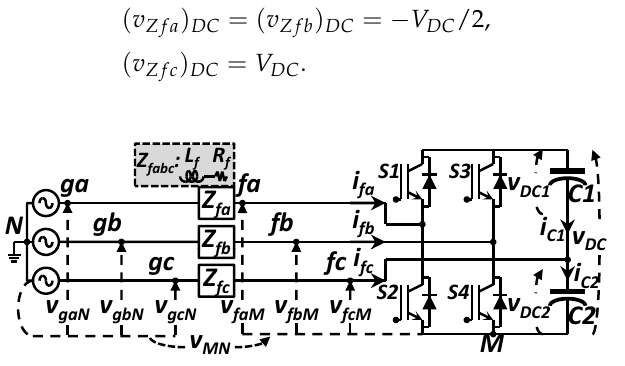
Figure 5. Simplified schematic of the GSC. Table 1. Voltage levels at the GSC terminals in different operation